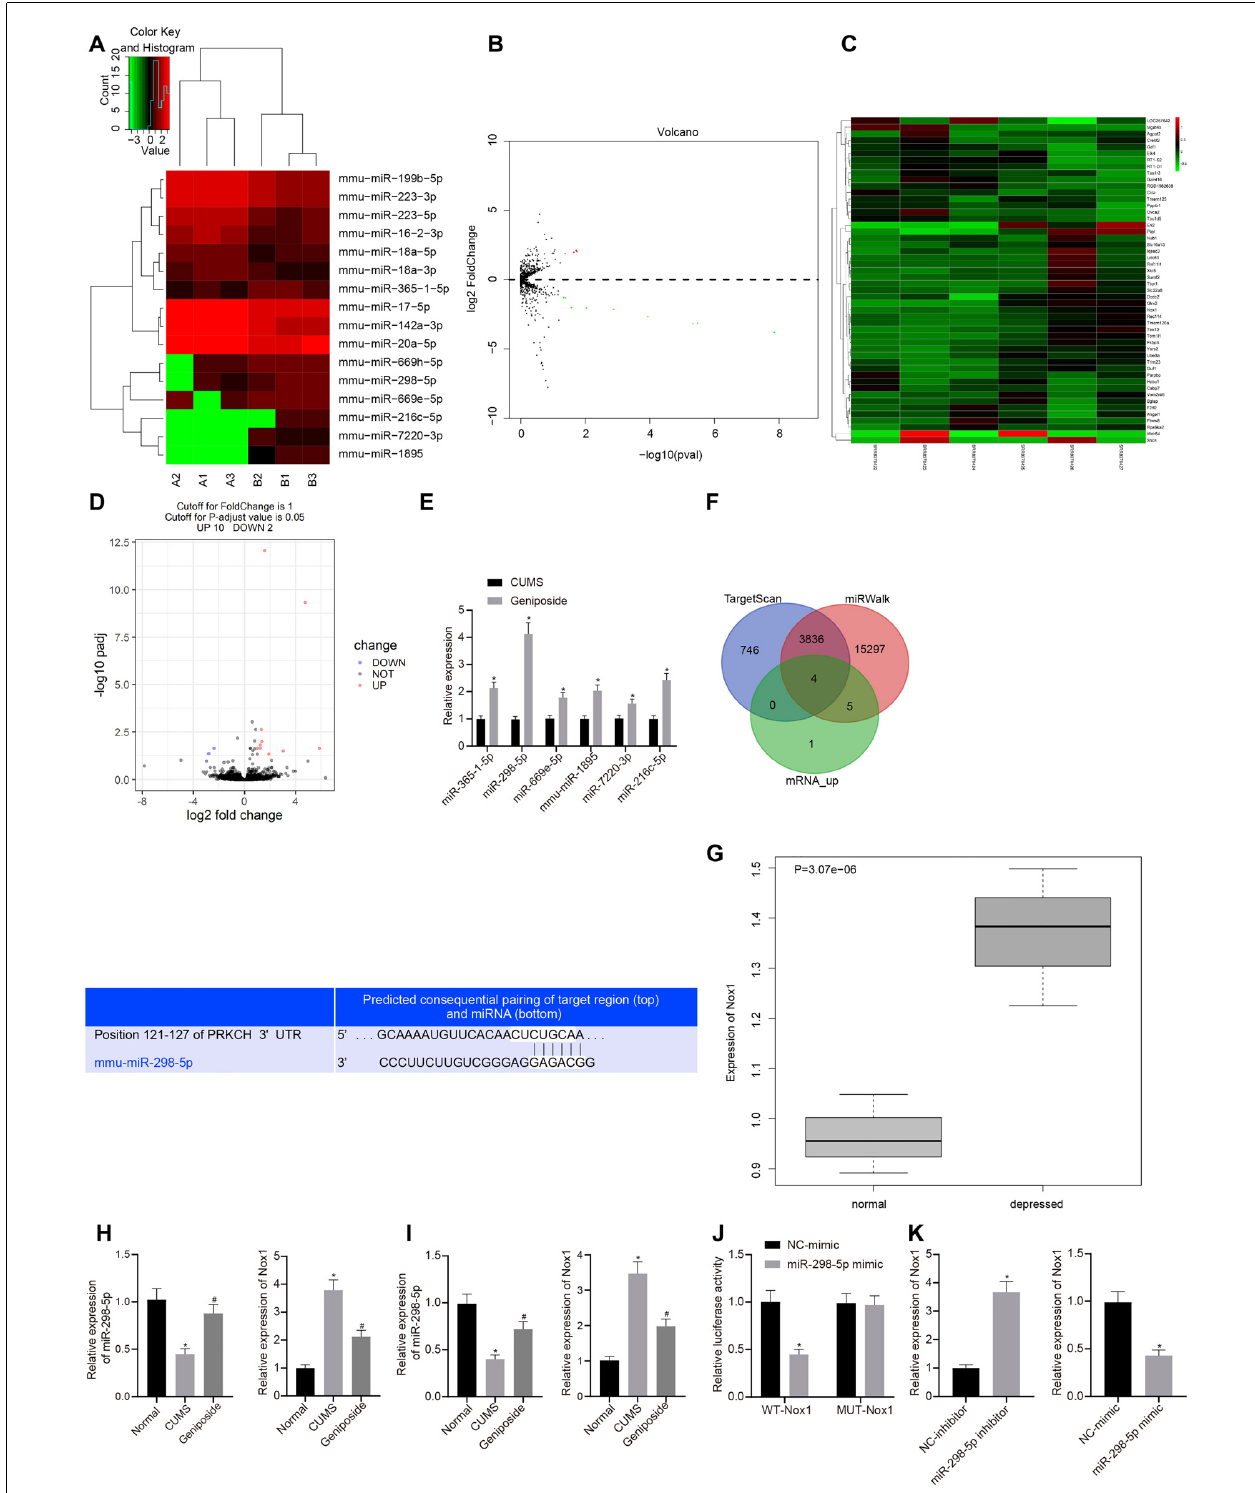
FIGURE 1 | Nox1 was inhibited by miR-298-5p in mouse frontal cortical neurons. (A) The heat map of microRNAs (miRNAs) with significantly differential expression between chronic unpredictable mild stress (CUMS) mice and normal mice. (B) A volcano map of miRNAs with significantly differential expression between CUMS mice and normal mice. (C) The heat map of mRNAs with significantly differential expression between CUMS mice and normal mice. (D) A volcano map of mRNAs